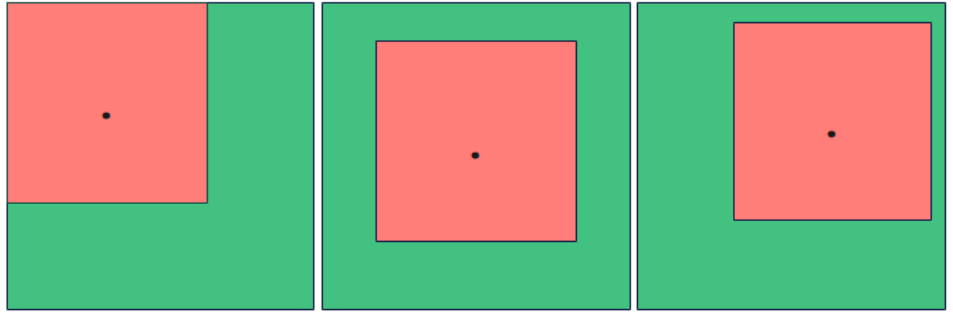
Figure 7. Same GIOU